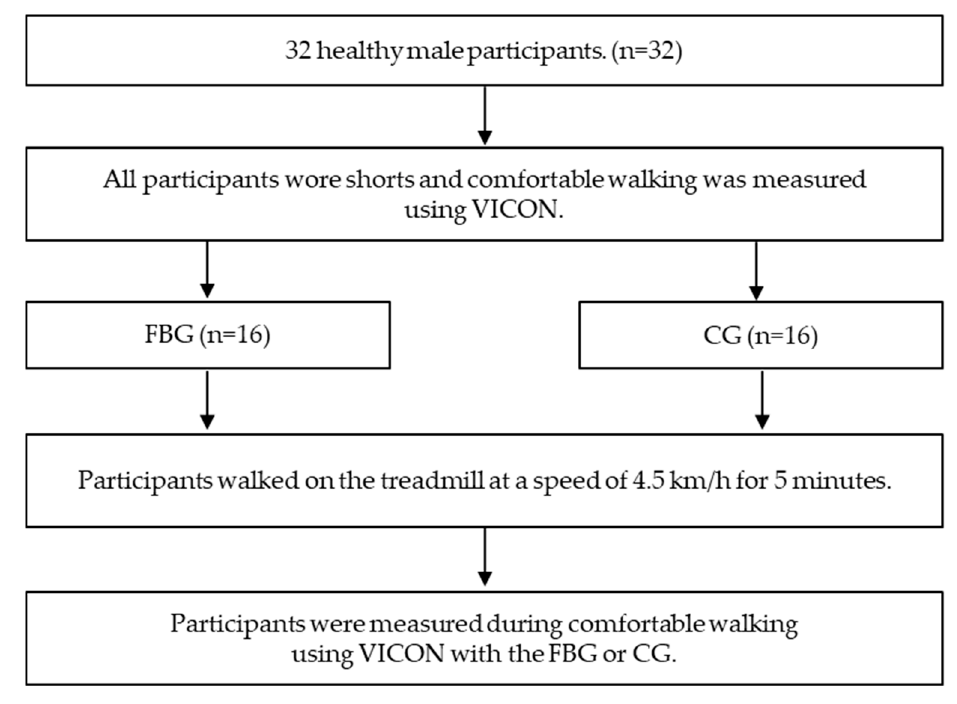
Figure 2. Experimental procedure.